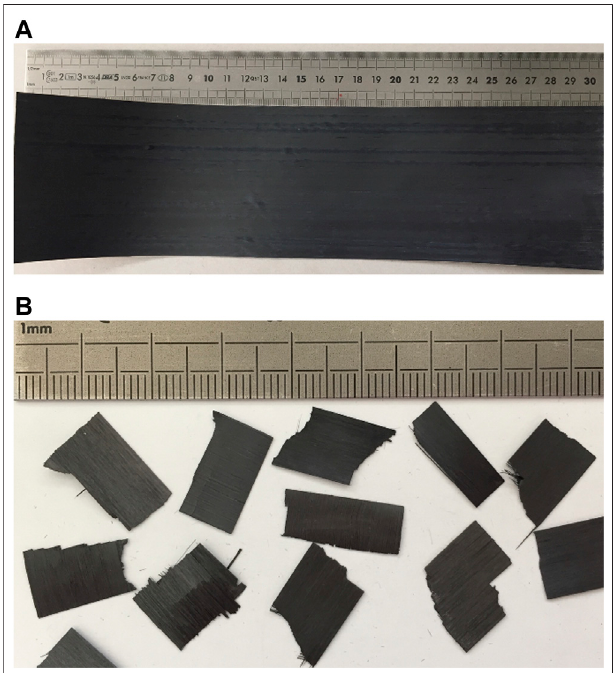
FIGURE1|(A) Fullviewofcompositepre-pregsscraps. (B) Micrograph of the shredded multi layers.